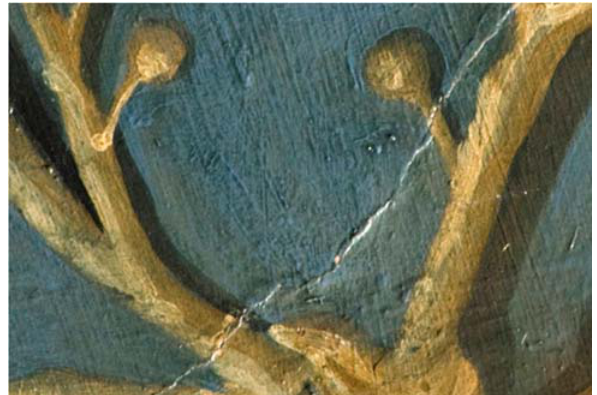
Figure 1. Detail of painted ceiling, taken in 2011, illuminated by raking light, showing an extended crack. The camera was mounted on a tripod at floor level.